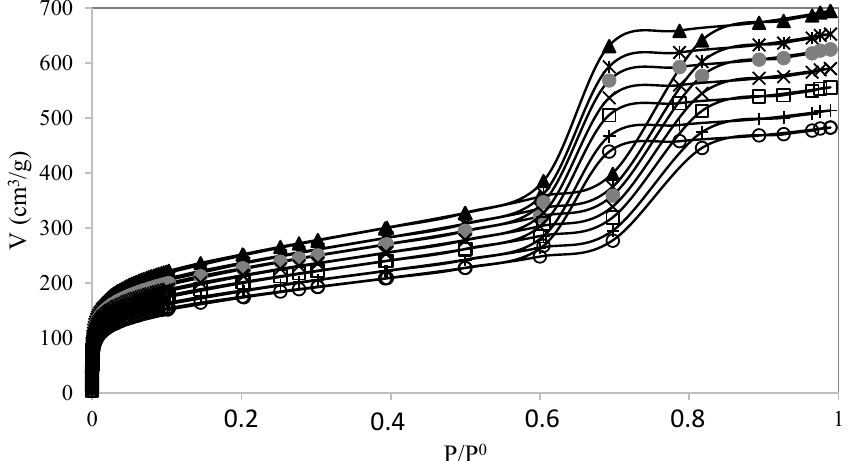
Figure 10. Hydration of camphene over PW4-SBA-15-SO 3 H catalyst. Effect of the catalyst amount. ( A ) Camphene conversion (%) versus time (h): ( ) m = 0.48 g; ( ) m = 0.30 g; ( ) m = 0.10 g; Isoborneol selectivity (%): ( ) m = 0.48 g; ( ) m = 0.30 g; ( ) m = 0.10 g. ( B ) Camphene conversion Figure 2. N 2 isotherms of materials. ( ▲ ) SBA‑15; ( ∗ ) SBA‑15‑SO 3 H; ( Figure 2. N 2 isotherms of materials. ( ) SBA-15; ( ∗ ) SBA-15-SO 3 H; ( ) PW1-SBA-15-SO 3 H; ( × ) (%) and selectivity (%) to the isoborneol at 70 h of PW2-SBA-15-SO 3 H; ( ) PW3-SBA-15-SO 3 H; (+) PW4-SBA-15-SO 3 H; ( ) PW5-SBA-15-SO 3 H. Figure 3 shows the ATR-FTIR spectra of PW (A), SBA-15-SO 3 H (B), PW1-SBA-15-SO 3 H PW3-SBA-15-SO 3 H (E), PW4-SBA-15-SO 3 H (F), and PW5-SBA-15-SO 3 H (G). The PW material exhibited principal IR bands at 1080, 985, 890, and 839 cm − 1 , which were attributed to the ν as P-O a , W = O t , W-O c -W, and W-O e -W of the Keggin structure of PW, respectively [16,18]. Additionally,